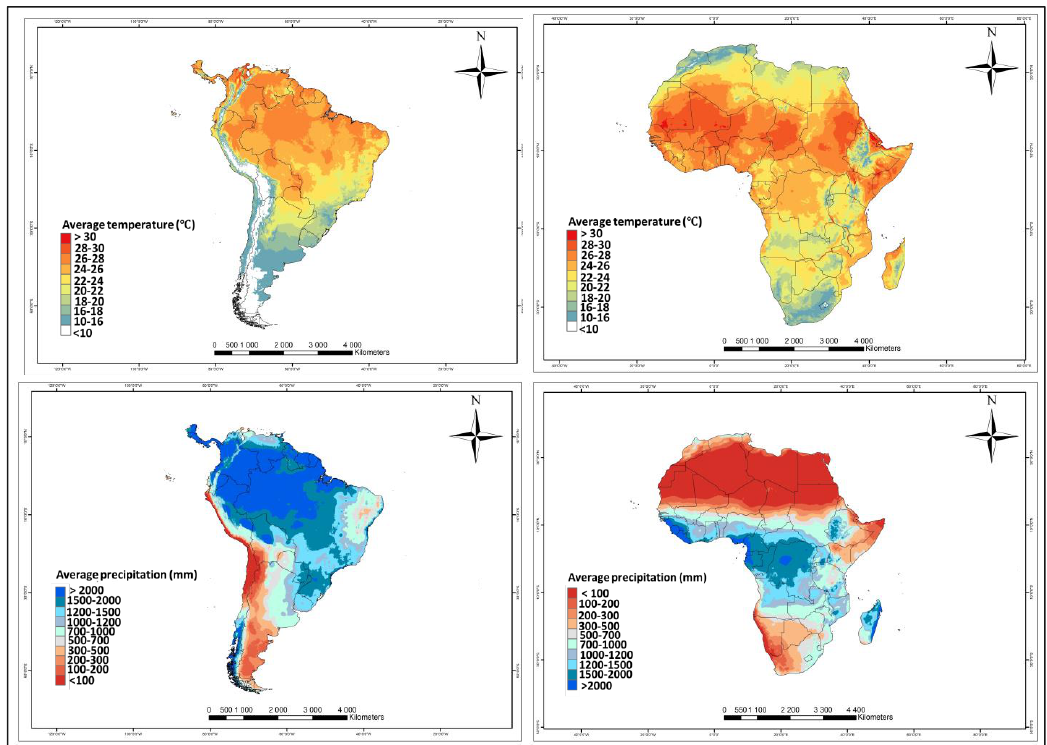
Figure 1. Temperature and precipitation comparison between the T. absoluta native (South America) and invaded (Africa) regions. The maps generally show that the T. absoluta niche is largely similar between the native and invaded region and thus successful establishment is possible. Maps were drawn in ArcGIS 10.3 from ESRI with data obtained from WorldClim Ver 2.0.